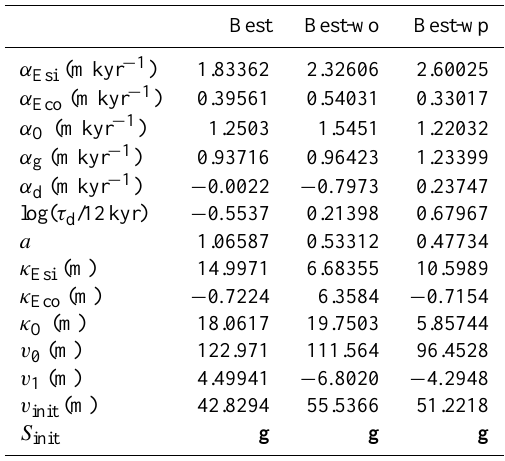
Table 2. Timing of the onset and end of terminations of the last million years and their estimated